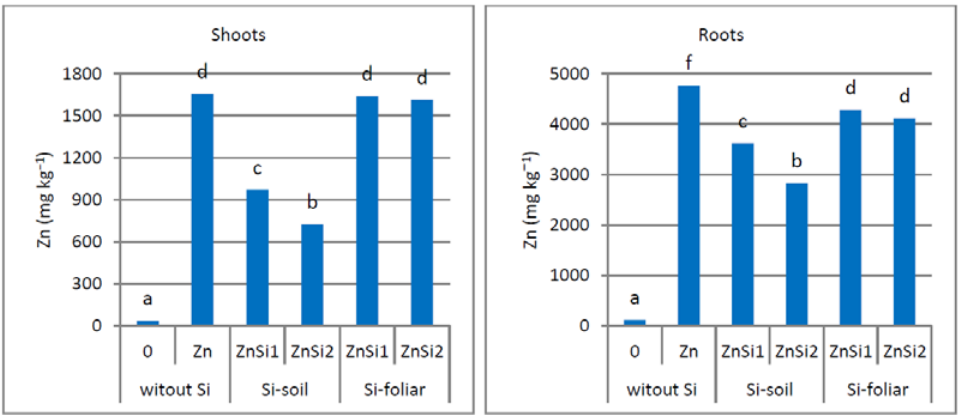
Figure 2. Zn concentration in shoots and roots of wheat. Values marked with the same letters indicate no significant difference according to Tukey ’ s test ( p < 0.05).